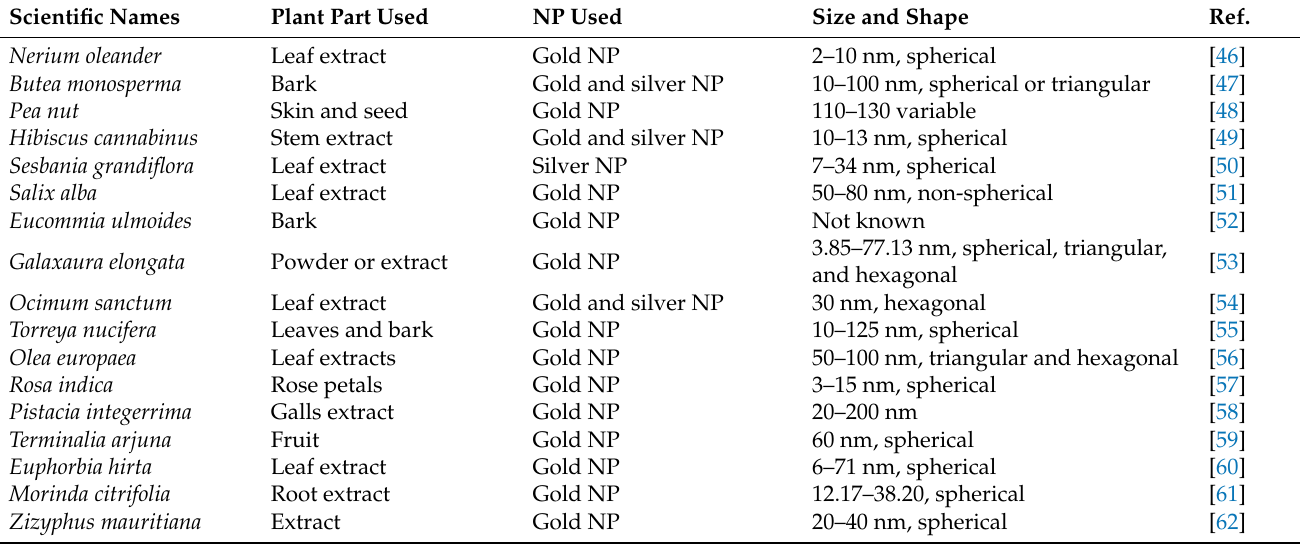
Table 2. Plants and their parts used in TB